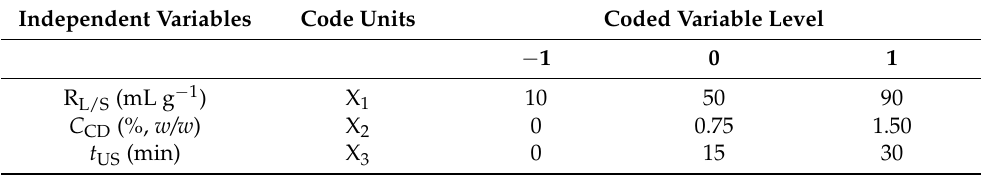
Table 1. Independent variables used for the response surface methodology and their